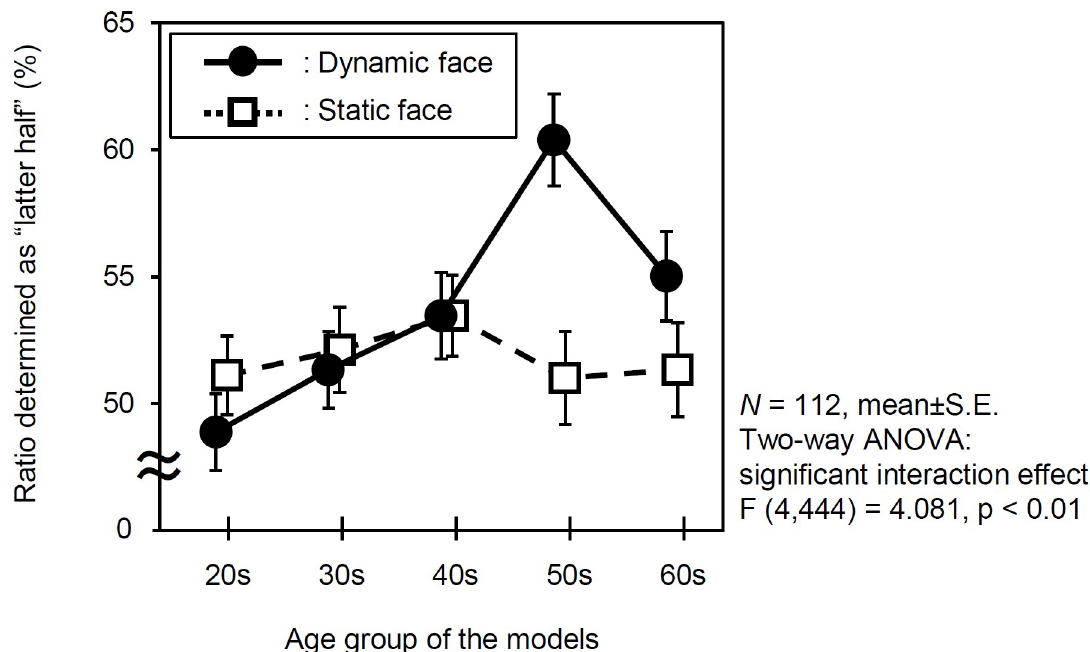
Fig 7. Effects of facial movements on age impression. The graph shows the percentages of 112 observers who thought the models to be in the older group, and their impressions after the dynamic and static conditions. The closed circles ( ● ) and open squares ( □ ) show the percentages of observers stimulated by dynamic and static stimulations, respectively. The marks and the vertical lines on the marks are mean values and standard errors, respectively.